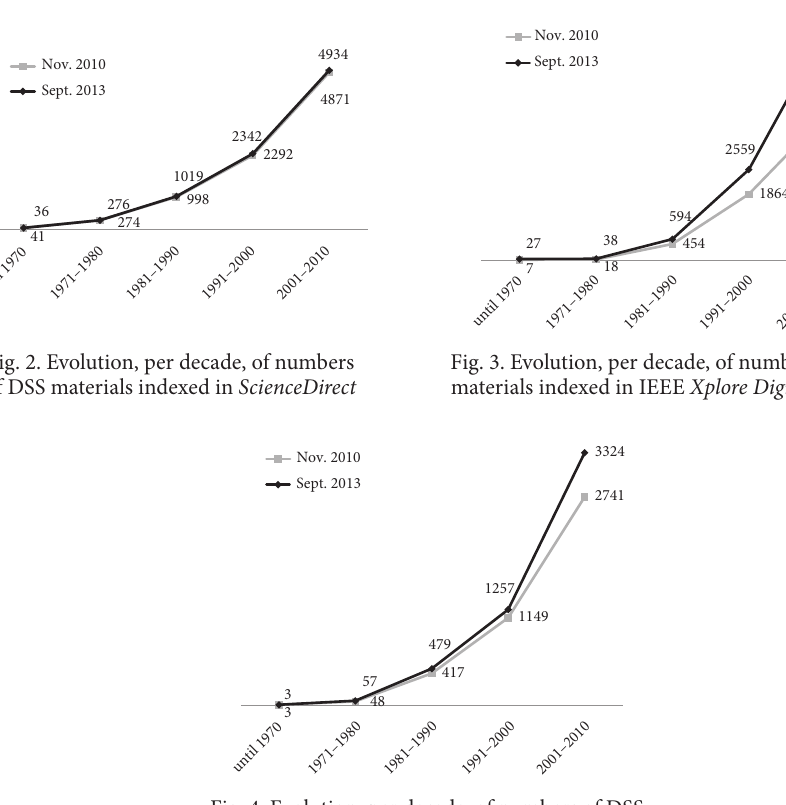
Fig. 4. Evolution, per decade, of numbers of DSS materials indexed in ACM Digital Library